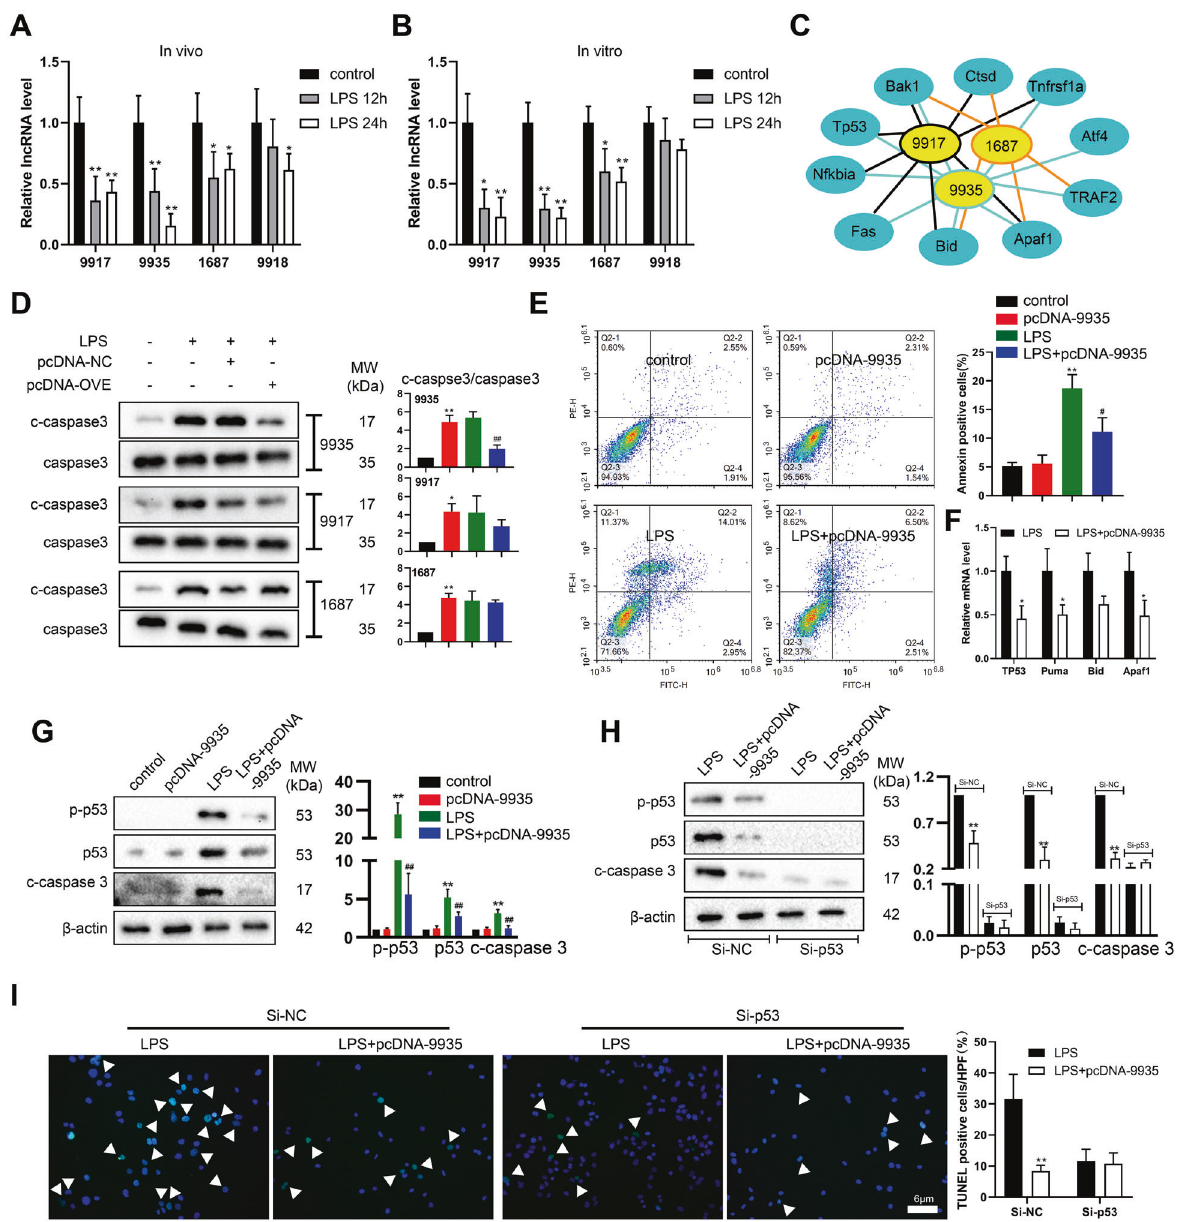
Fig. 2 Effect of lncRNA NONRATG019935.2 (9935) on LPS-induced renal tubular epithelial cell (RTEC) apoptosis in vitro. The expression levels of NONRATG019917.2 (9917), NONRATG001687.2 (1687), 9935, and NONRATG009918.2 (9918) in the A renal cortical of control ( n = 5), LPS 12 h ( n = 5), and LPS 24 h ( n = 5) rats; and B rat RTEC line NRK-52E treated with or without 10 µg/ml LPS (12 or 24 h). * P < 0.05, ** P < 0.01 vs. control. C The correlations between 9917/9935/1687 and apoptosis-related genes were analyzed by Pearson correlation analysis. Bak1 B- cell lymphoma 2-antagonist/killer 1, Ctsd cathepsin D, Tnfrsf1a tumor necrosis factor receptor superfamily member 1A, Atf4 activating transcription factor 4, Traf2 Tnf receptor-associated factor 2, Apaf1 apoptotic peptidase activating factor 1, Bid BH3 interacting domain death agonist, Fas Fas cell surface death receptor, Nfkbia nuclear factor-kappa B inhibitor alpha, Tp53 tumor protein p53. D The cleaved caspase 3 (c- caspase 3) protein level was measured in LPS-treated NRK-52E cells transfected with pcDNA-9935/9917/1687 overexpressing vector (OVE) or corresponding negative control (pcDNA-NC) using western blot. Caspase 3 was served as a control. * P < 0.05, ** P < 0.01 vs. control; ## P < 0.01 vs. LPS + pcDNA-NC. E – G NRK-52E cells were transfected with/without pcDNA-9935 and then treated with or without LPS. E Cell apoptosis was measured by fl ow cytometry. ** P < 0.01 vs. control; # P < 0.05 vs. LPS. F The mRNAs levels of Tp53 , Bcl-2 binding component 3 ( Puma ), Bid , and Apaf1 were measured by qRT-PCR. * P < 0.05 vs. LPS. G The protein levels of phospho-p53 (p-p53), p53, and c-caspase 3 were measured using western blot with β -actin as an internal control. ** P < 0.01 vs. control, ## P < 0.01 vs. LPS. H , I NRK-52E cells were divided into four groups: si-NC + LPS, si-NC + LPS + pcDNA-9935, si-p53 + LPS, si-p53 + LPS + pcDNA-9935. H The protein levels of p-p53, p53, and c-caspase 3. ** P < 0.01 vs. LPS + si-NC. I TUNEL staining was performed to determine cell apoptosis. Triangles: TUNEL-positive cells (green). The nuclei were counterstained with DAPI. ** P < 0.01 vs. LPS +